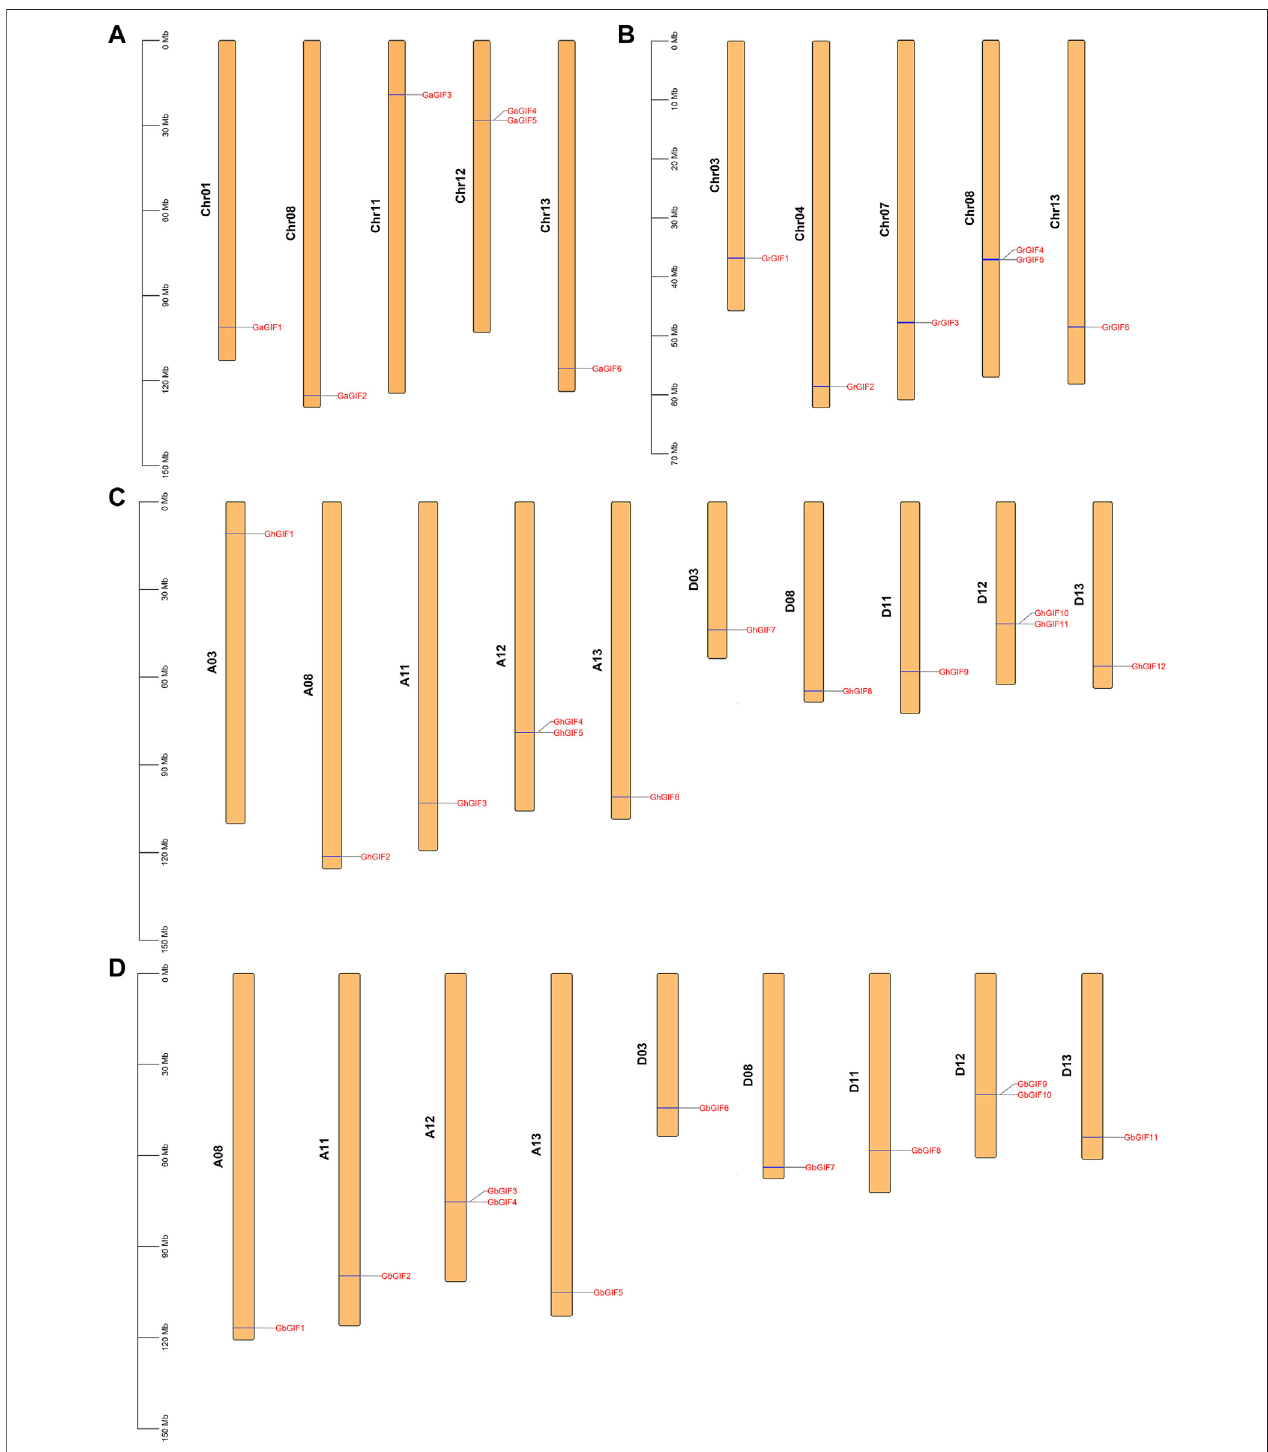
FIGURE 1 | Chromosome distribution of GIF genes in four Gossypium species. (A) G. arboreum (B) G. raimondii (C) G. hirsutum (D) G. barbadense.